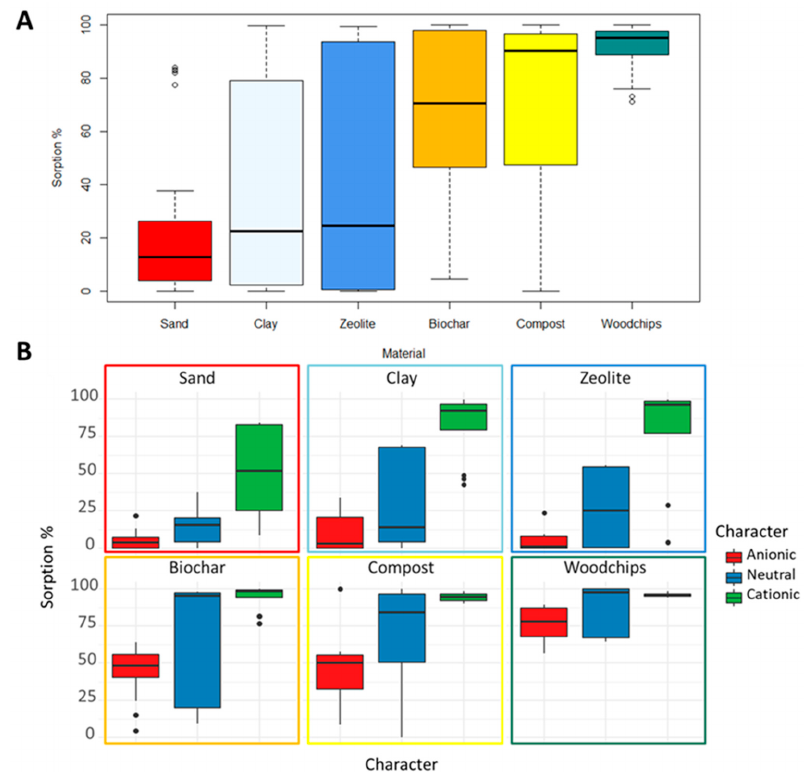
Figure 3. Boxplot displaying the distribution (outliers; 25th, 50th, and 75th percentiles; and maximum) of the sorption of the 12 studied PhACs ( A ). The sorption of anionic (red), neutral (blue), and cationic (green) species ( B ) on sand (red), clay (pale blue), zeolite (dark blue), biochar (orange), compost (yellow), and woodchips (dark green).